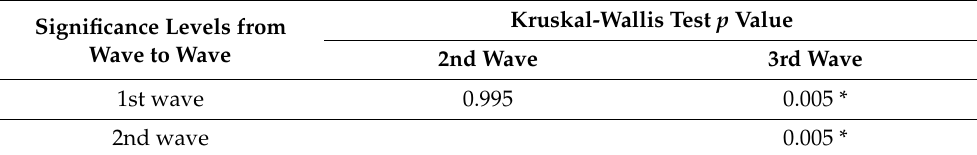
Table 4. Significance levels of the differences of sporting habits under the different waves of the pandemic. Significance Levels from Wave to